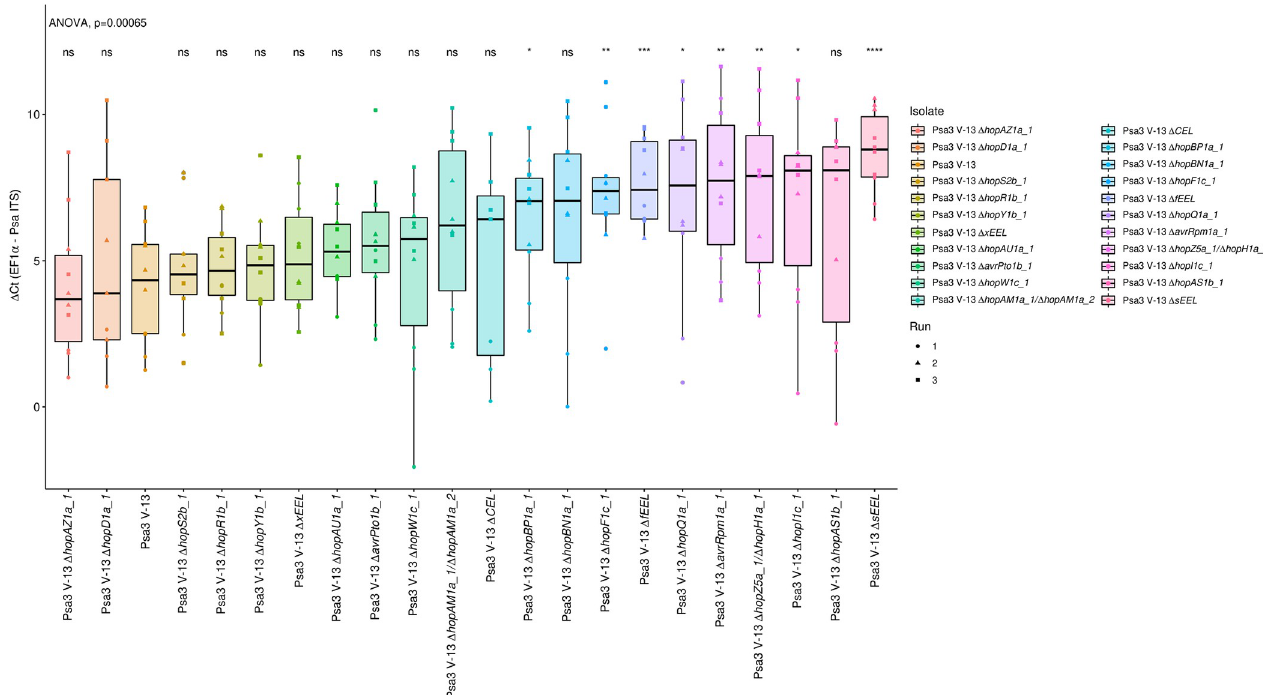
Fig 3. Pathogenicity assay screen of Psa3 V-13 effector knockout strains in Actinidia arguta identifies four avirulence loci. A . arguta AA07_03 kiwifruit plantlets were flood-inoculated at approximately 10 6 cfu/mL. Psa biomass ( ITS ) was quantified relative to AaEF1 α using the Δ Ct analysis method for three pseudobiological replicates, per strain, per experimental run. Box and whisker plots, with black bars representing the median values and whiskers representing the 1.5 inter-quartile range. Asterisks indicate the statistically significant difference of Student’s t -test following ANOVA between the indicated strain and wild- type Psa3 V-13, where p � .05 ( � ), p � .01 ( �� ), p � .001 ( ��� ), p � .0001 ( ���� ), and p > .05 (ns; not significant). This experiment was separately conducted three times (biological replicates) with three batches of independently grown plants and data were stacked to generate the box